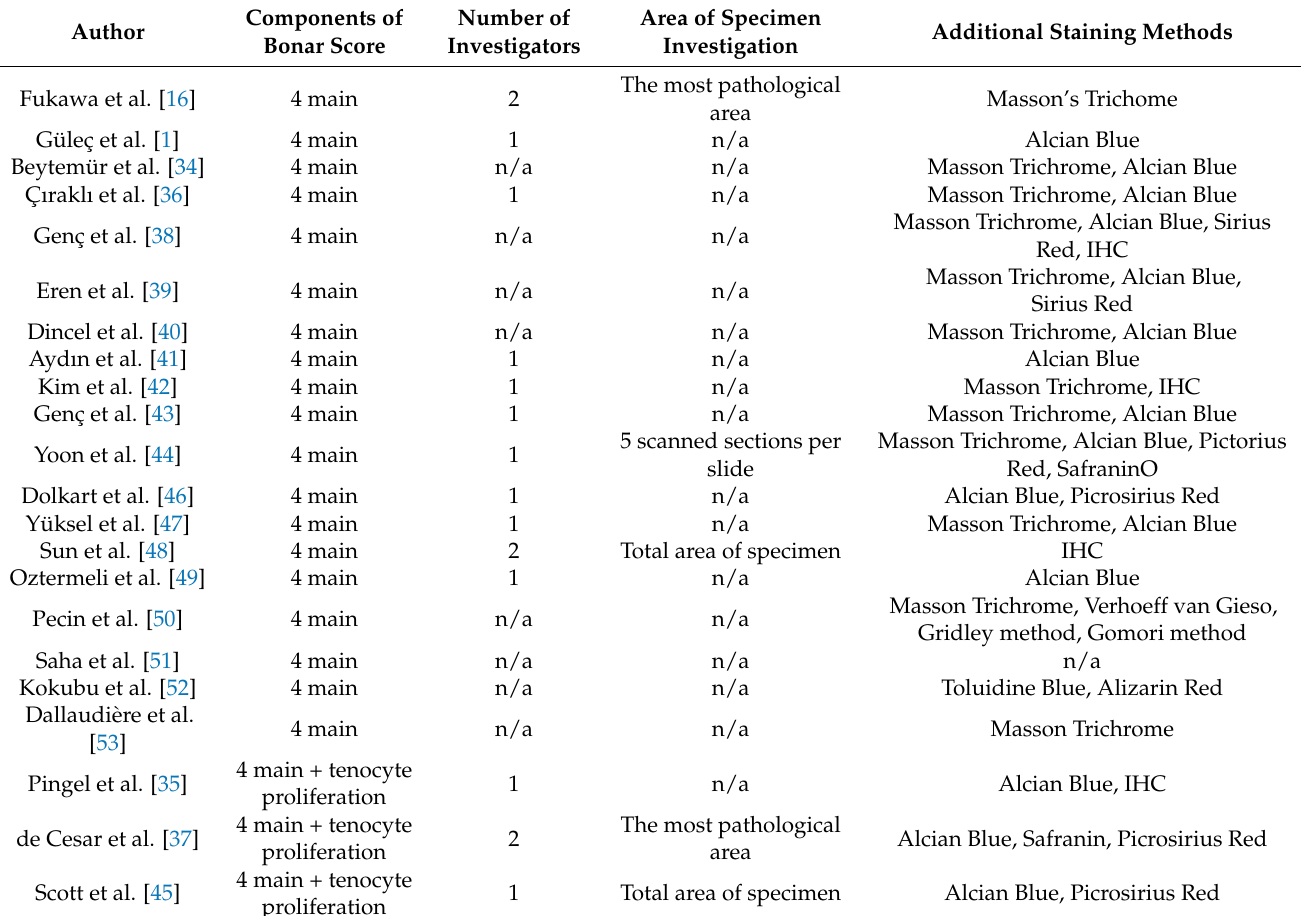
Table 2. Methodology of microscopic investigation in the included